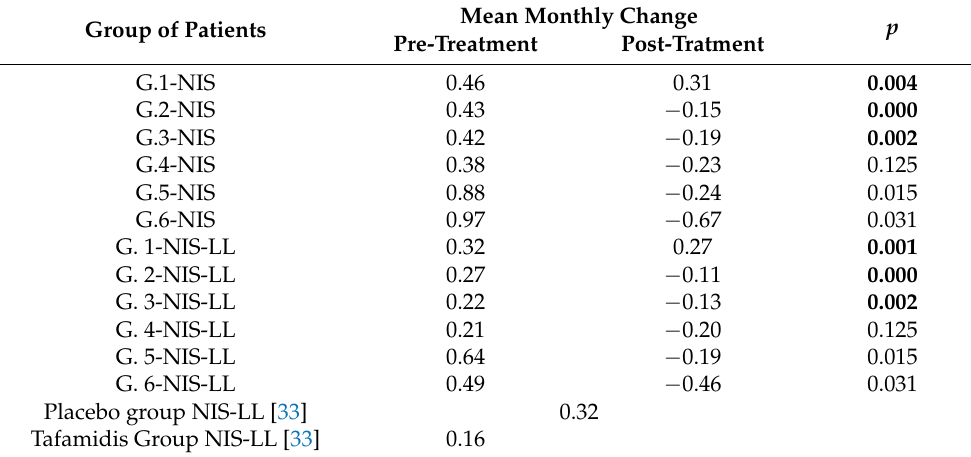
Table 2. NIS and NS-LL statistical analysis